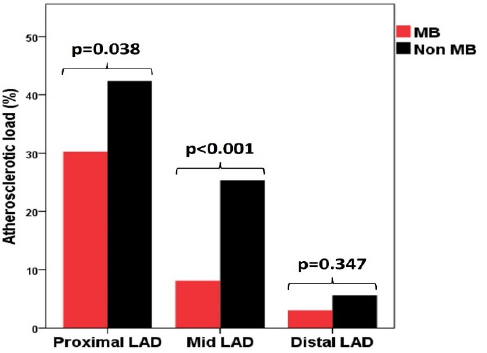
Figure 1. Distribution of atherosclerotic load in the three segments of de left anterior descending artery in MB group and non-MB group. LAD—left anterior descending artery; MB—myocardial bridge.